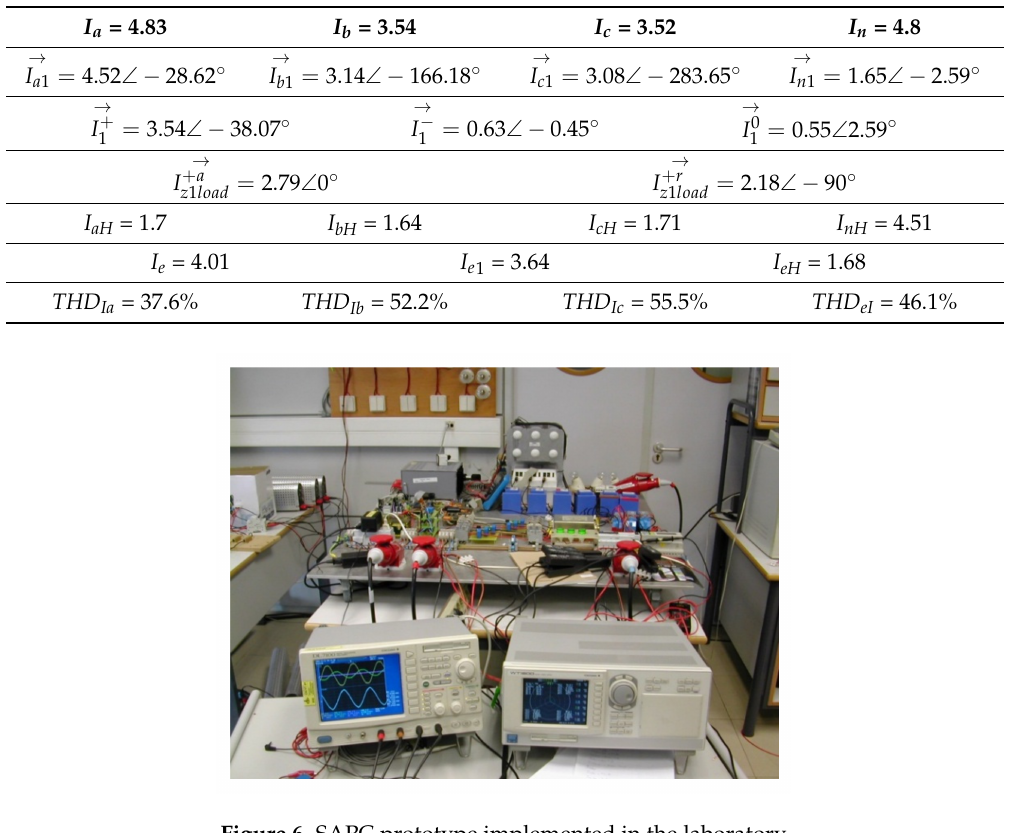
Figure 6. SAPC prototype implemented in the